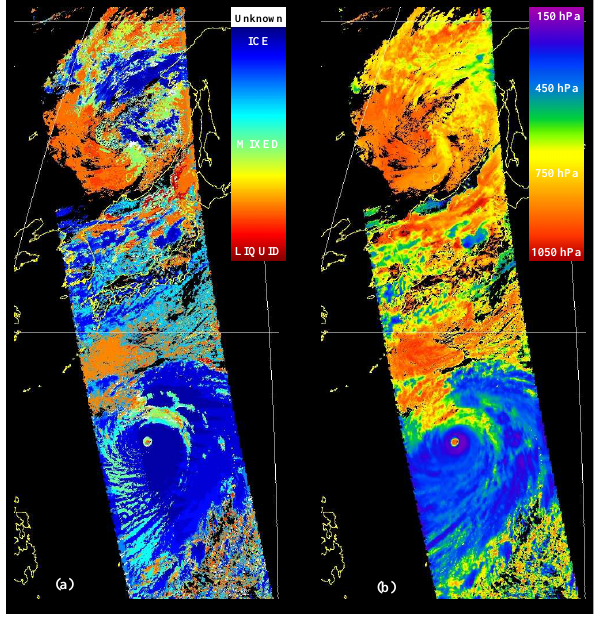
Fig. 10. (a) Results of the final cloud phase index retrieved from a combination of POLDER and MODIS data. (b) Cloud top pressure derived from POLDER oxygen A-Band